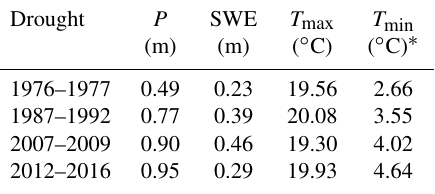
Table 1. Average precipitation ( P ), snow water equivalent (SWE), and maximum and minimum daily temperature ( T max and T min , re- spectively) across the four California droughts under